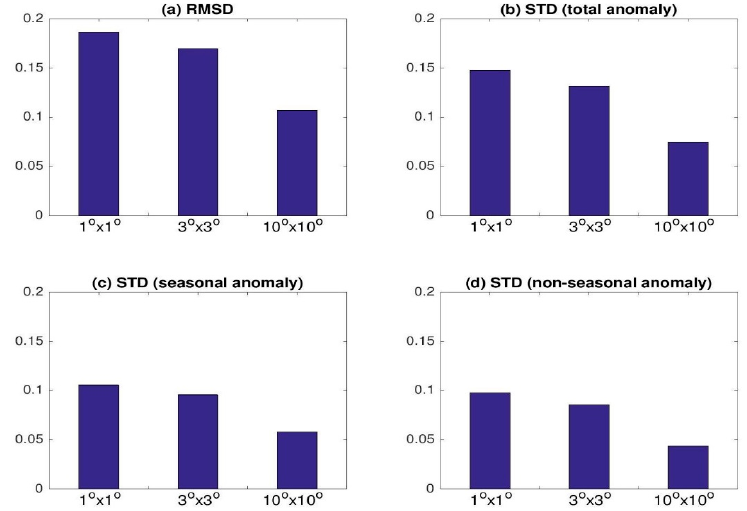
Figure 6. ( a ) Global average of regional temporal RMSD values between Aquarius and Argo-SIO SSS on various spatial scales as indicated by legends along the horizontal axis. Global average of regional temporal STD values for the differences between Aquarius and Argo-SIO SSS on various spatial scales for ( b ) total anomalies; ( c ) composite seasonal anomalies; and ( d ) non-seasonal anomalies. All RMSD and STD values are in the unit of psu.